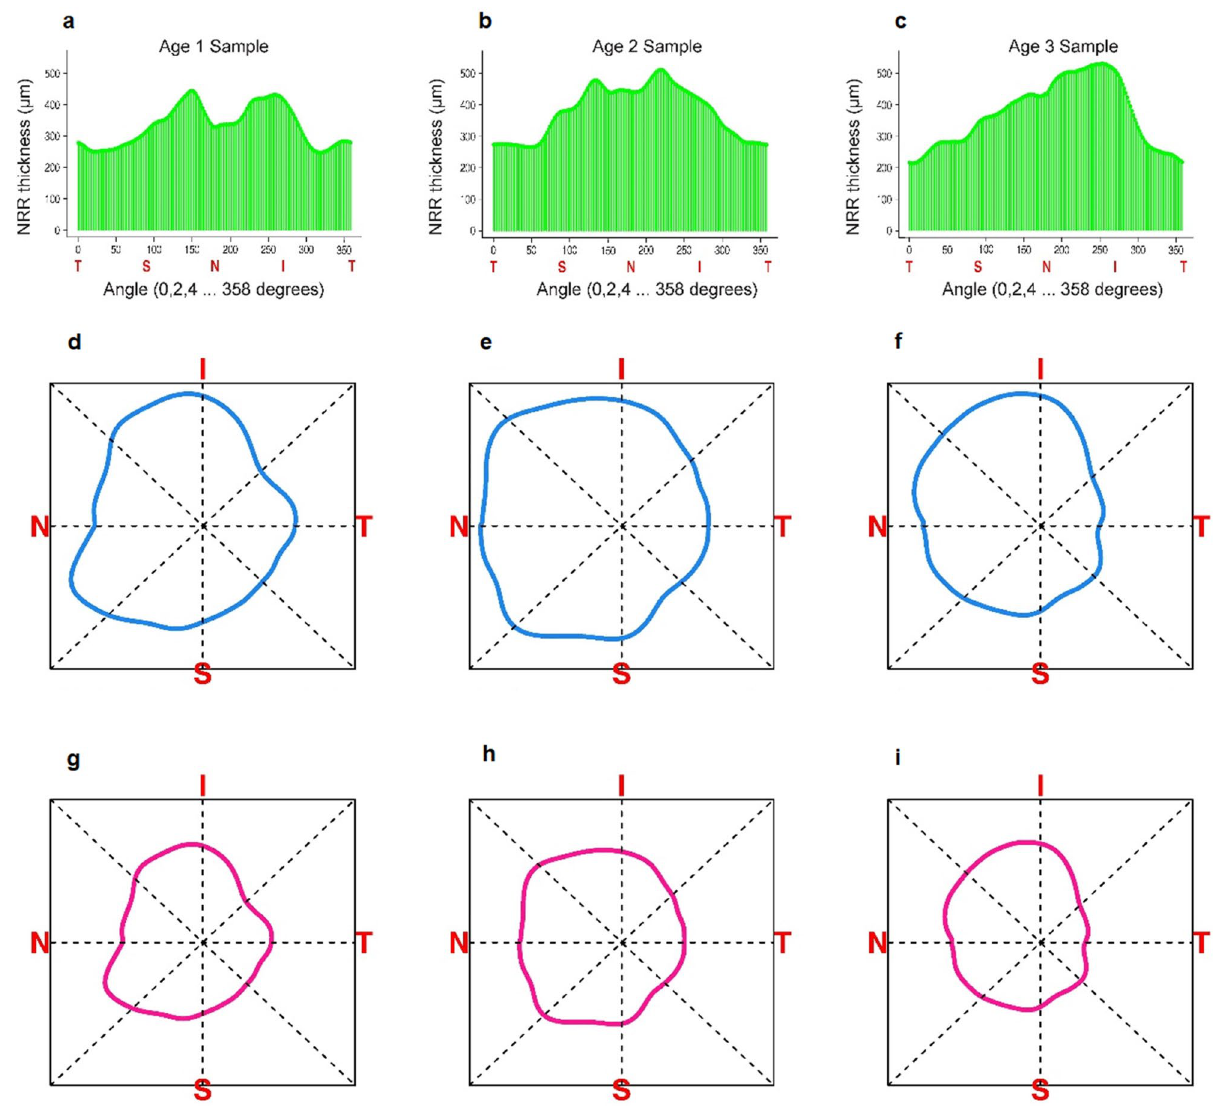
Figure 2. For 3 real samples, selected from each age group (1 to 3 from left to right), the NRR thickness data measured for 180 evenly-spaced points around the circle is shown in the top panel. The corresponding circular functional approximations are shown as pre- and post-normalized NRR curves in the middle and the bottom panels respectively. The direction of the NRR curves is given by TSNIT